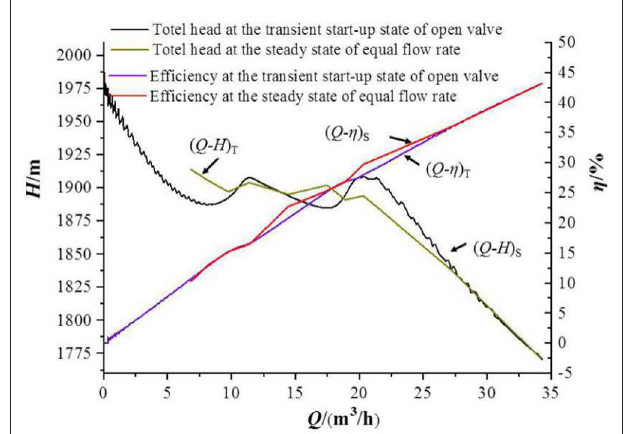
FIGURE 14 | Head change of different stages in transient start-up state during open-valve stage. maximum value appears, and then the head decreases again. At t = 1.61 s, the local minimum value appears, and then the head starts to rise again. Near t = 1.89 s, the second local maximum value appears, and the two maximum values are almost equal.